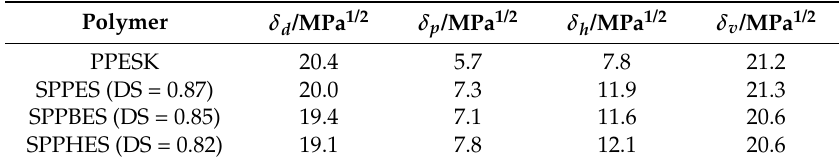
Table 1. Solubility parameters of poly(phthalazinone ether sulfone ketone)s (PPESK) and sulfonated poly(aryl ether sulfone)s.